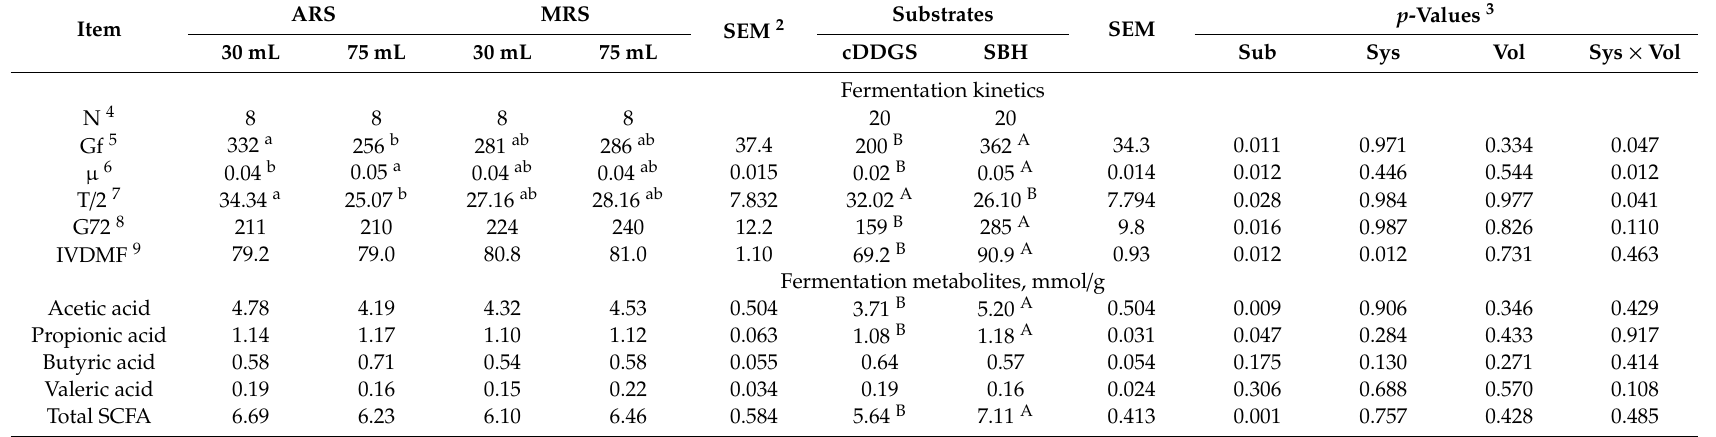
Table 1. Parameters of the fitted kinetics and concentration of short-chain fatty acids (SCFA) after in vitro fermentation of corn distillers dried grains with solubles (cDDGS) and soybean hulls (SBH) using an automatic recording system (ARS) and manual recording system (MRS) using di ff erent fecal inoculum volumes (30 and 75 mL) obtained from pigs 1